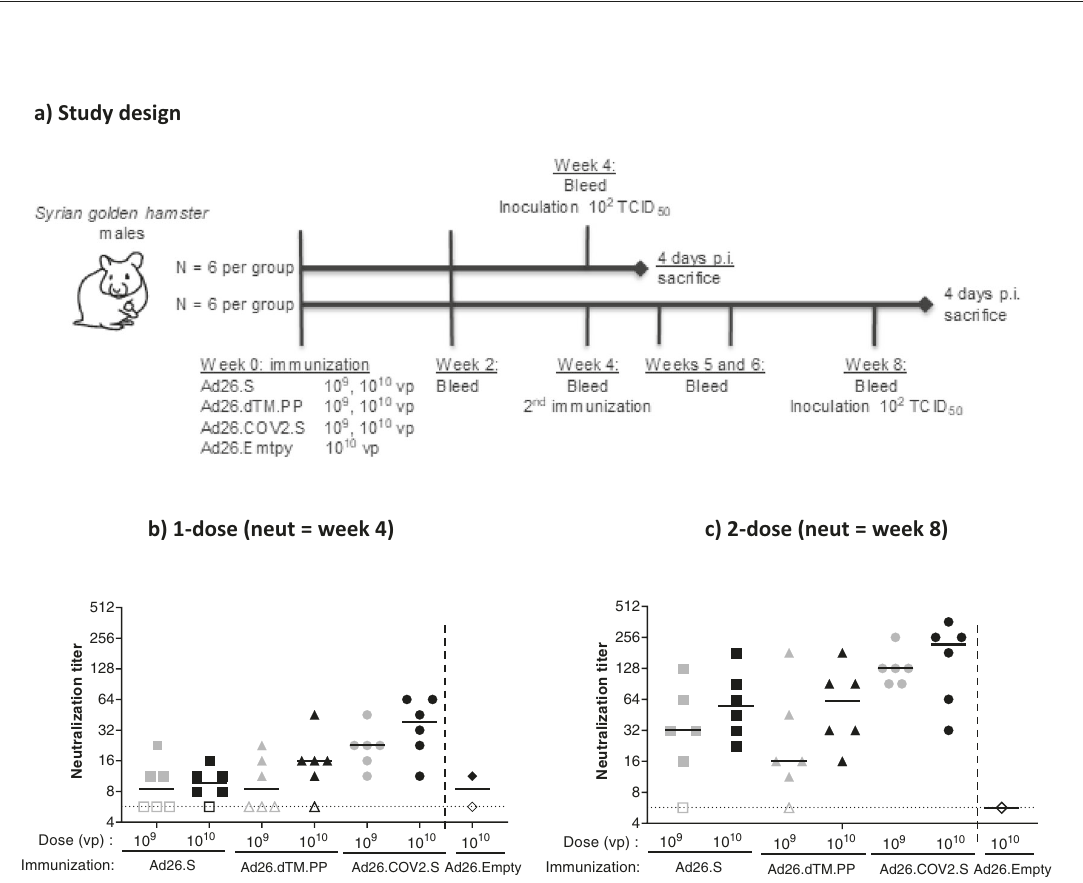
Fig. 1 Titration of SARS-CoV-2 challenge dose and characterization of histopathology in Syrian hamsters. Syrian hamsters ( N = 12 per group) were inoculated intranasally with 10 2 , 10 3.3 , 10 4.6 , or 10 5.9 TCID 50 SARS-CoV-2 BetaCoV/Munich/BavPat1/2020 or mock-inoculated with Vero E6 cell-supernatant . Daily throat swabs were taken, and 2, 3, 4, and 7 days p.i., three hamsters per group were sacri fi ced and nose and lung tissue collected for virological analysis and histopathology. Replication-competent viral load in a lung tissue, b nose tissue, and c throat swabs was determined by TCID 50 assay on Vero E6 cells. LLOD was calculated per animal per gram or milliliter of tissue, and animals with a response at or below the LLOD are shown as open symbols. d Lung tissue was analyzed and scored for presence and severity of alveolitis, alveolar damage, alveolar edema, alveolar hemorrhage, type II pneumocyte hyperplasia, bronchitis, bronchiolitis, peribronchial and perivascular cuf fi ng. Sum of scores are presented as sum of LRT disease parameters (potential range: 0 – 24). e Nose tissue was analyzed and scored for severity of rhinitis on a scale from 0 to 3. Dotted lines indicate the minimal and maximal scores of histopathology. Median responses per group are indicated with horizontal lines and error bars in panel c indicate the range. p.i. post inoculation, LLOD lower limit of detection, LRT lower respiratory tract, N number of animals, TCID 50 /g 50% tissue culture infective dose per gram tissue, TCID 50 /mL 50% tissue culture infective dose per milliliter sample, VP virus particles.